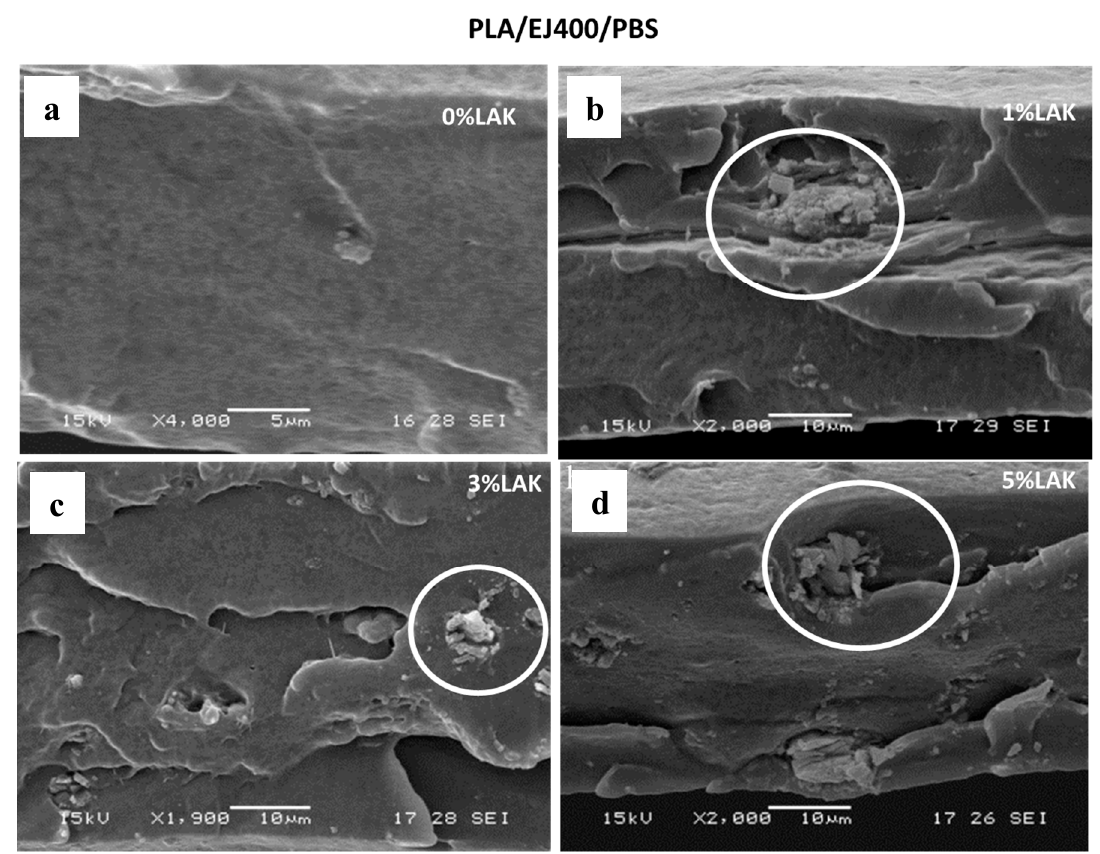
Figure 7. SEM micrographs of cryogenic-fracture films based on PLA/EJ400/PBS containing different amount of LAK: ( a ) 0% LAK; ( b ) 1% LAK; ( c ) 3% LAK; ( d ) 5% LAK.